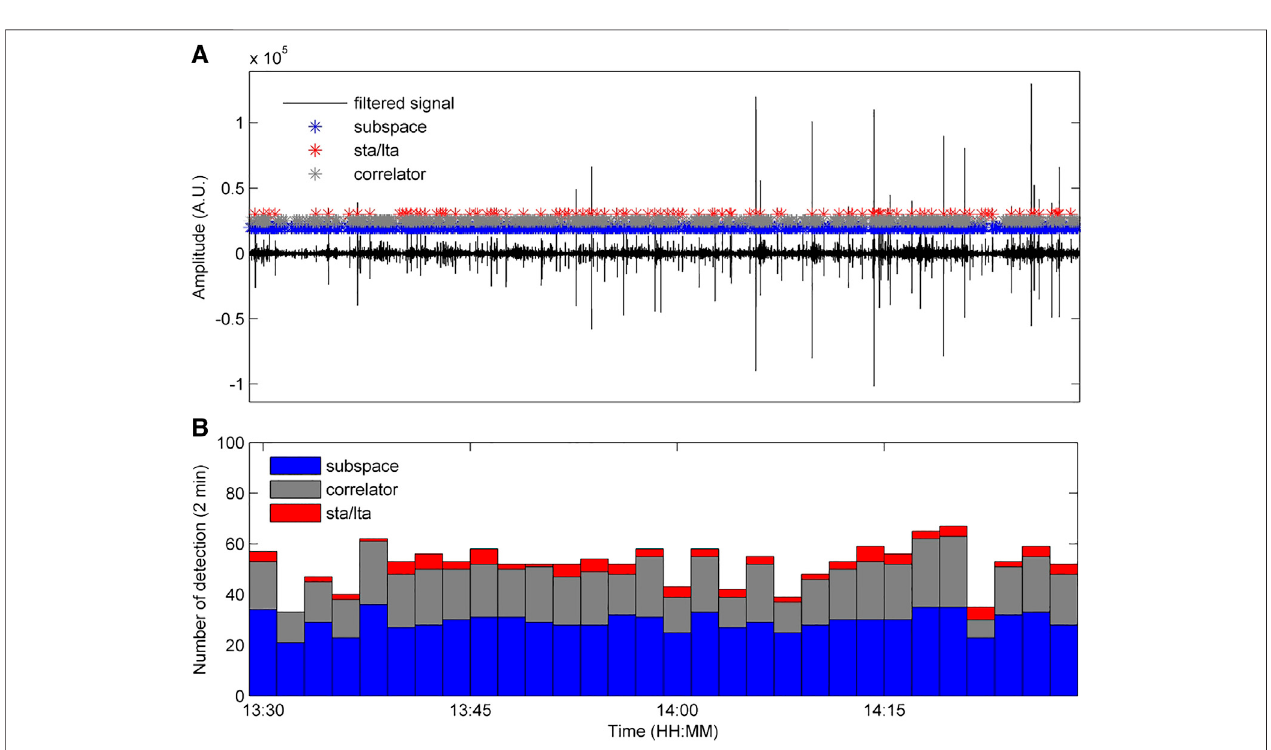
FIGURE7| SignalrecordedatEMFOstationand fi lteredintheband1 – 10 Hzwiththeoverlappedpositionsofdetectionsobtainedin1-slongwindowbysubspace (blueasterisks),correlation(greenasterisks)andSTA/LTA(redasterisks)detectionalgorithmsfor99.9percentileandusingfourSVD (A) .Eventoccurrencerateresulting from STA/LTA, correlation and subspace (bottom) detection algorithms counted in 2-min-long window (B) .